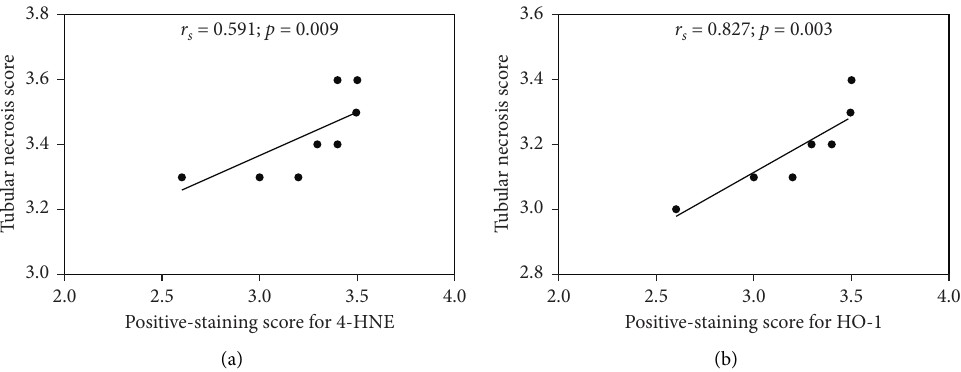
Figure 5: Correlation between the tubular necrosis score and the positive staining scores for 4-HNE (a) and HO-1 (b) in the kidney sections of the P. berghei -infected group ( n � 10). The correlations among the data were analyzed by Pearson’s correlation, and significance was indicated by p < 0 .